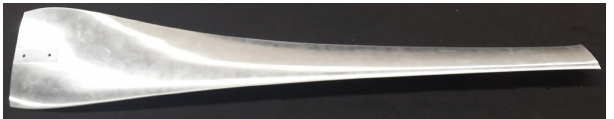
Figure 10. Aluminium rotor blade.